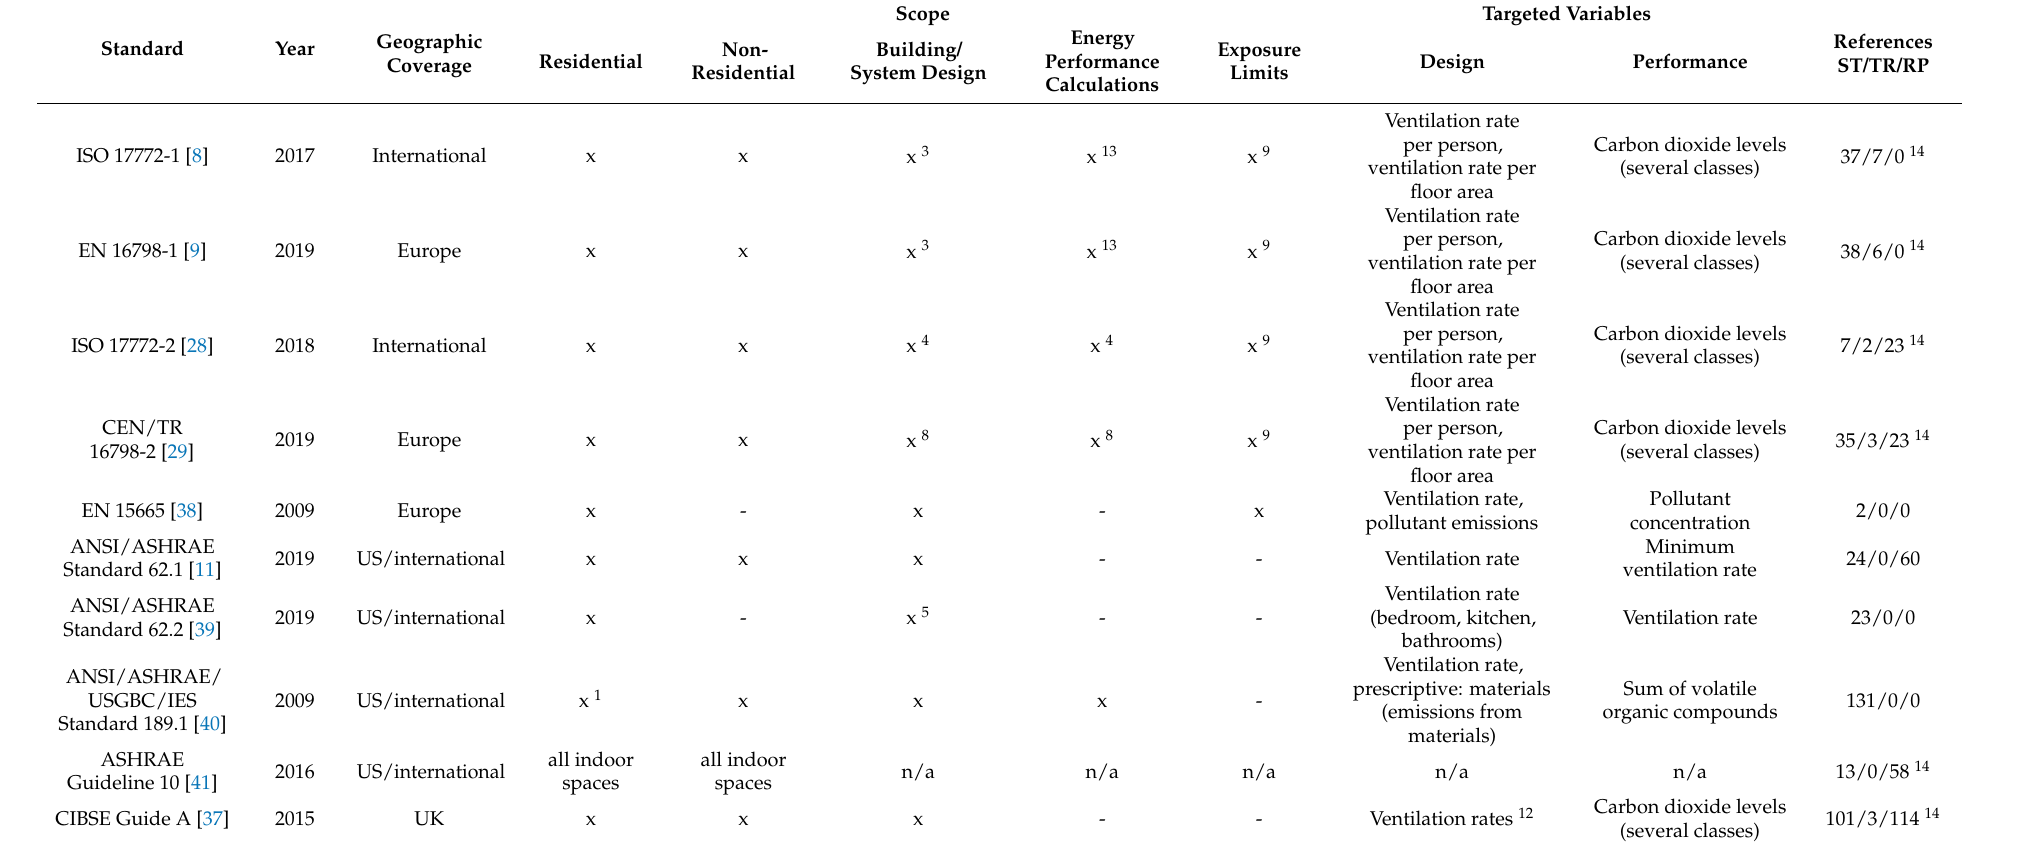
Table 3. Analysis of selected standards (note that ST refers to standard; TR to technical reports, and RP to research